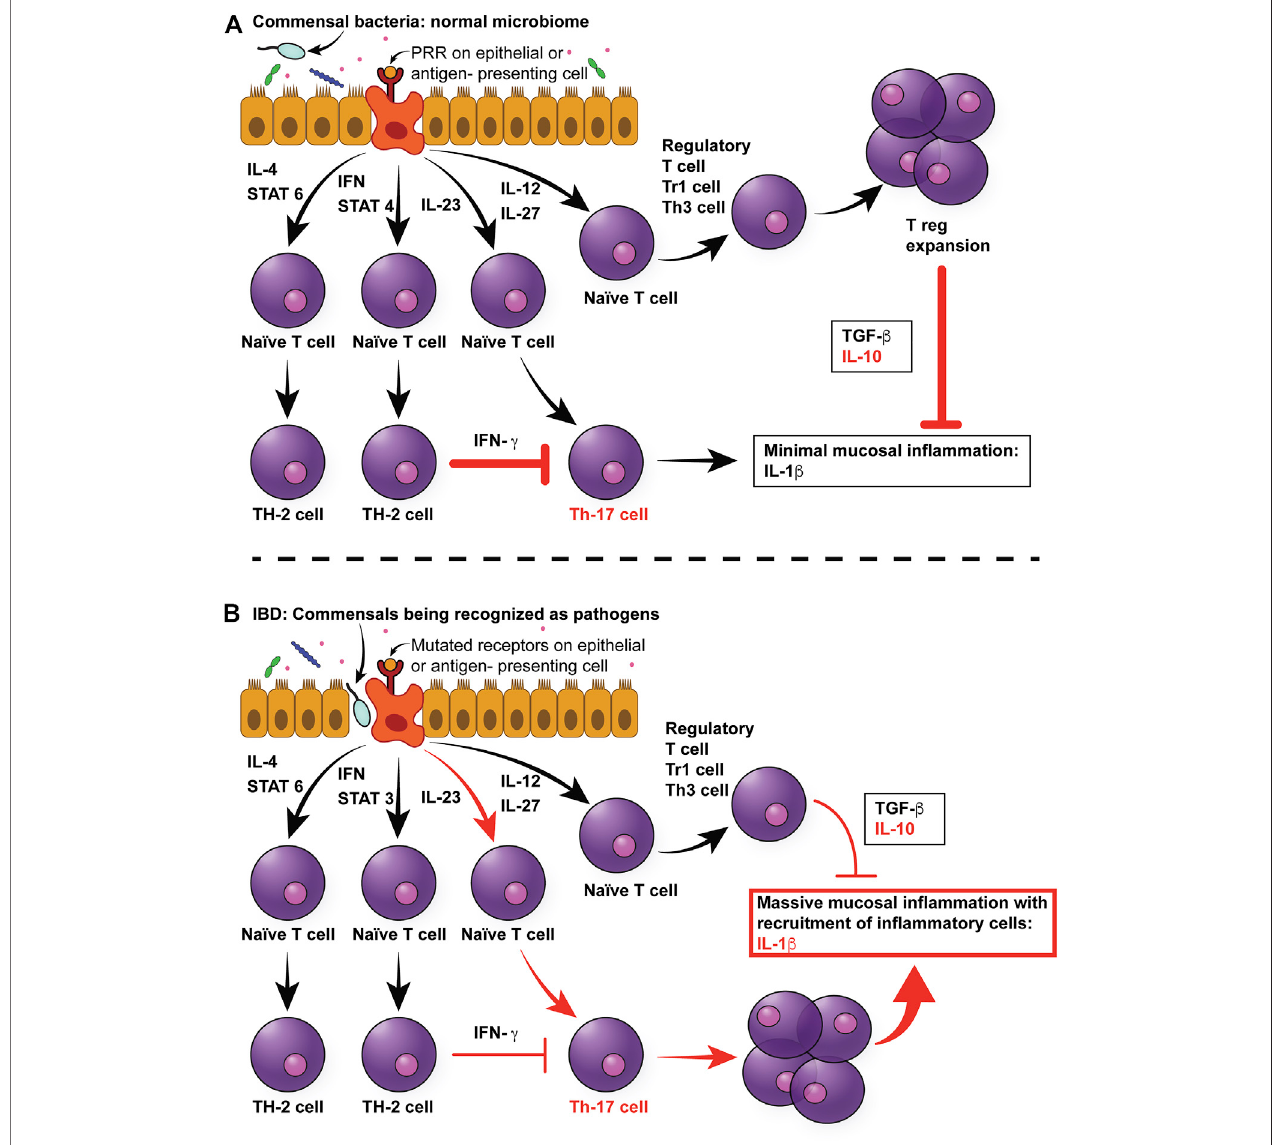
FIGURE 1 | Multifactorial pathophysiology of canine IBD. (A) In the normal intestinal mucosa, Toll-like receptors (TLRs) sample pathogen-associated molecular patterns (PAMPs) from commensals in the intestinal lumen, which send signals to naïve T cells to differentiate primarily into T regulatory cells, which produce anti- in fl ammatory cytokines, such as TGF-beta and IL-10. (B) In the case of canine IBD, microbial dysbiosis drives the messaging toward a pro-in fl ammatory pathway of Th celldifferentiation, resultingintheproduction ofpro-in fl ammatorycytokines, mainlyIL-1beta.Inaddition, mutationsinpatternrecognitionreceptors, suchasTLR5, resultinhyper-responsivenessto fl agellin.SincethedysbiosisincanineIBDischaracterizedbyanincreasein Enterobacteriaceae (whichexpress fl agellin),thiswillfurther increasepro-in fl ammatoryresponsesofthemucosa.Moreover,thein fl ammatorycytokineswillleadtoarchitecturalchangesinepithelialcells,suchasincreasedleakage through tight junction, and therefore increased permeability. This in turn will result in more bacteria breaching the mucosal barrier, therefore leading to a self-enhancing circle of in fl ammation. IL-4: Interleukin 4, IFN: Interferon, STAT3: Signal Transducer And Activator Of Transcription 3, IL-23: Interleukin-23, IL-12: Interlleukin-12, IL-27: Interleukin-27, TGF-beta: Tissue growth factor-beta, IL-10: Interleukin-10, IL-beta: